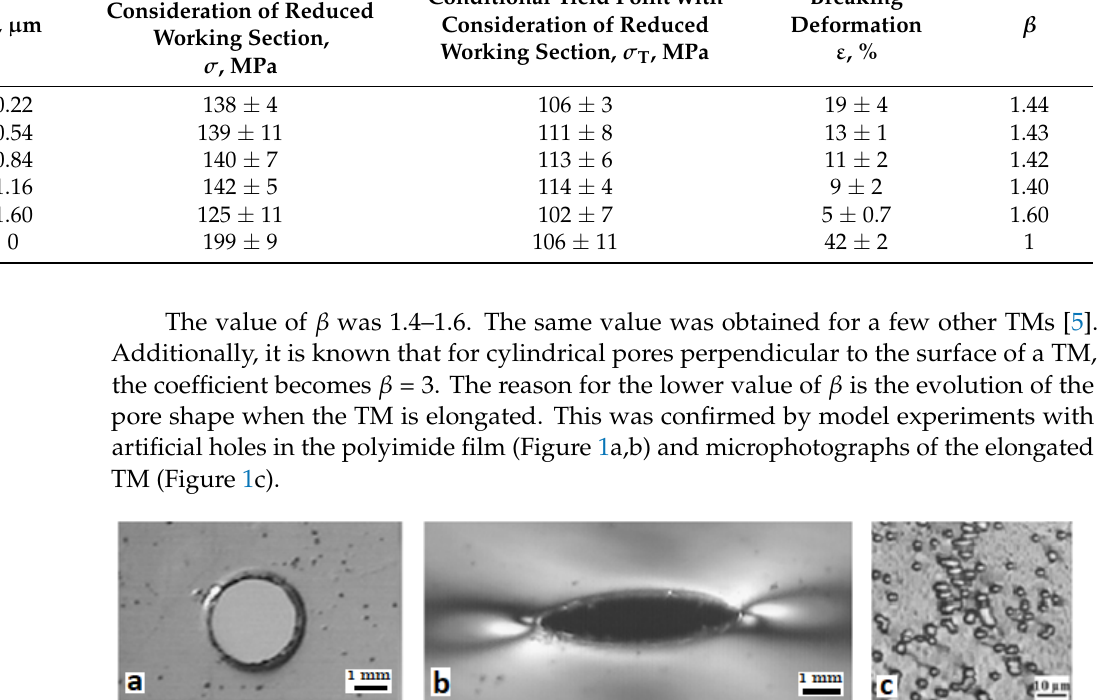
Table 3. Tensile strength and mechanical characteristics of tested TM.